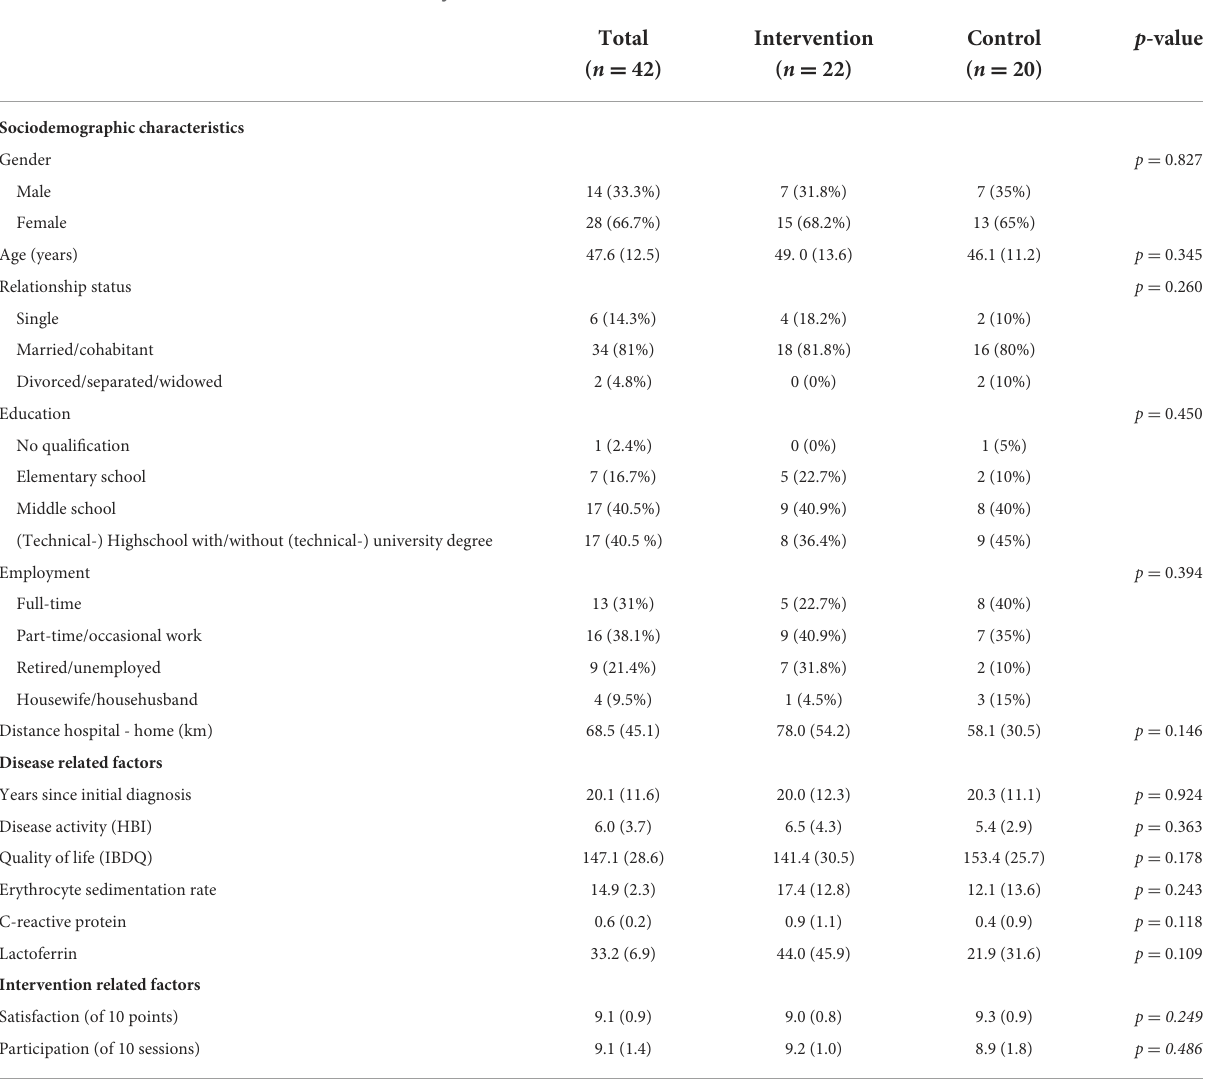
TABLE 2 Patient characteristics at baseline of the study and intervention related factors.